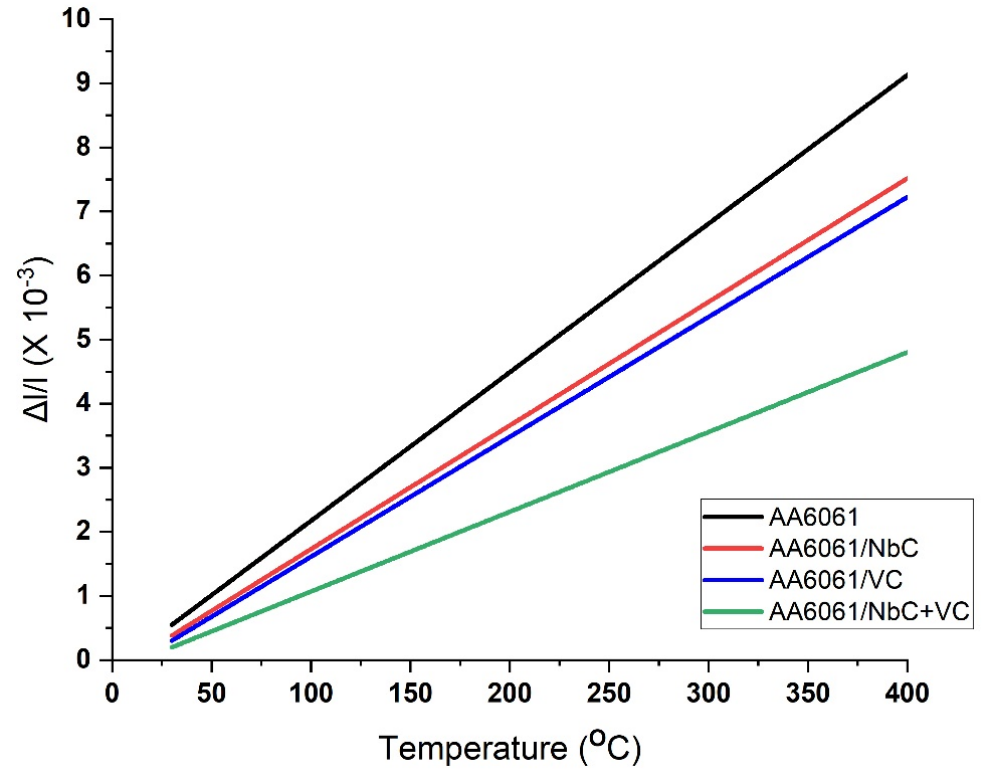
Figure 5. Thermal expansion behavior of Al 6061 and composite samples.